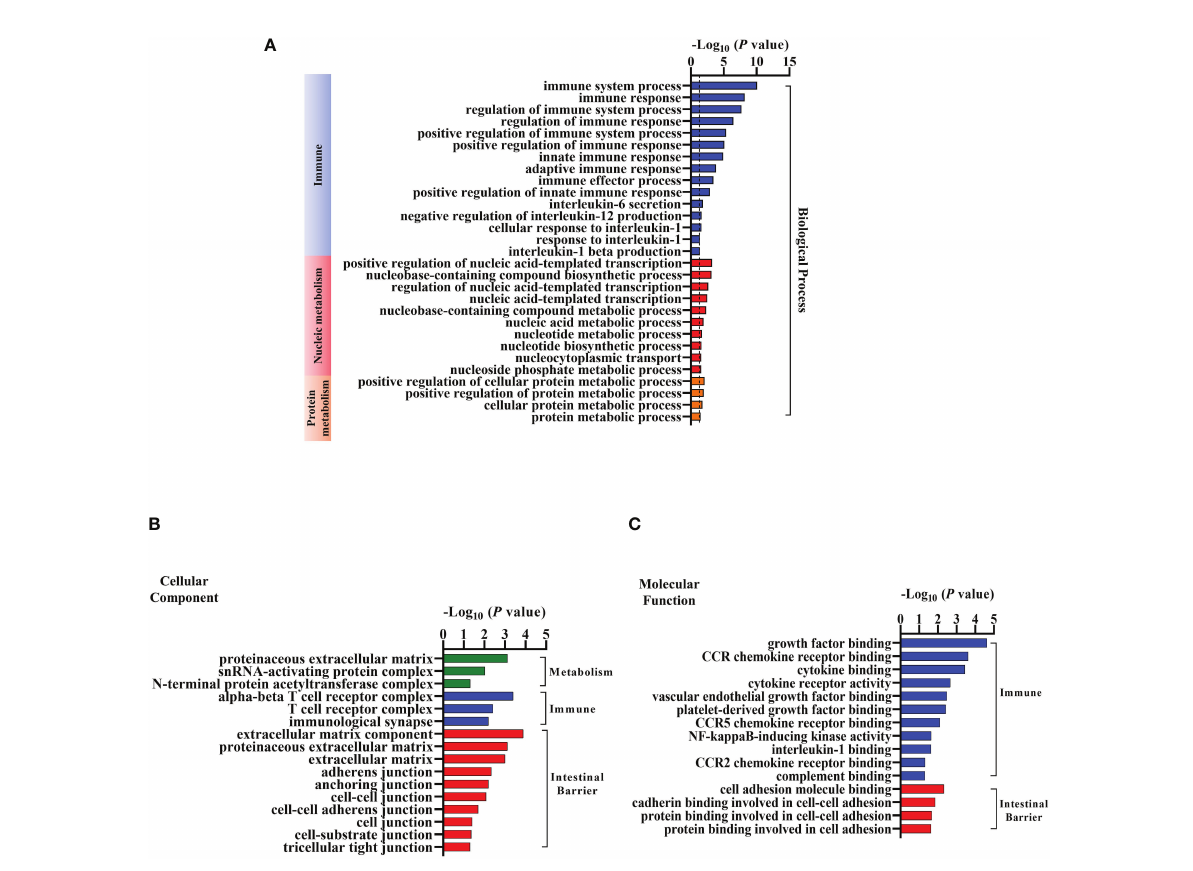
FIGURE 4 Gene Ontology (GO) Analysis of the differentially expressed mRNAs in the colonic tissues after the protoscoleces of Echinococcus granulosus infection. Go annotation of differently expressed mRNAs between the Control and Infected group (n = 3). (A) Biological process related to immune, nucleic or protein metabolism. (B) Cellular components connected with metabolism, immune and intestinal barrier. (C) Molecular function associated with immune and intestinal